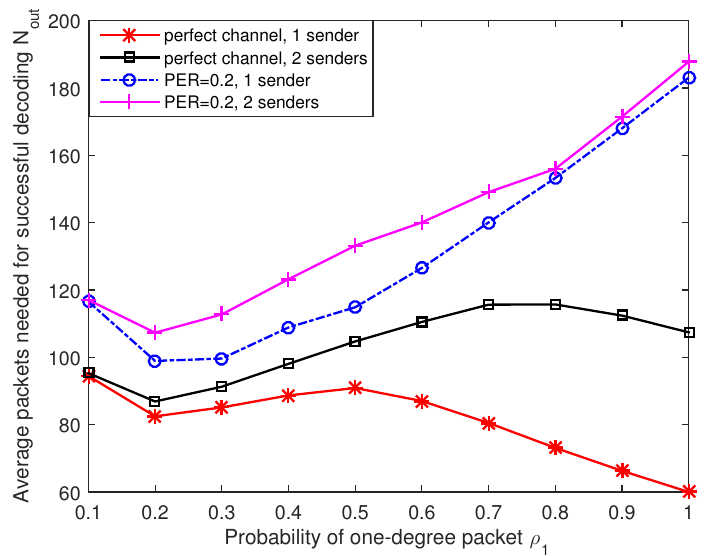
Figure 6. Average number of needed output packets for different probabilities of one-degree packets